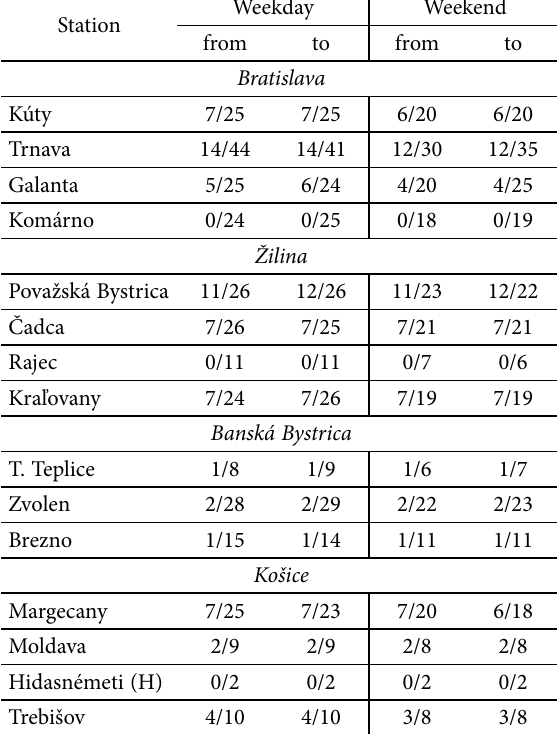
Table 4. Accessibility of trains in chosen regions of Slovakia Station